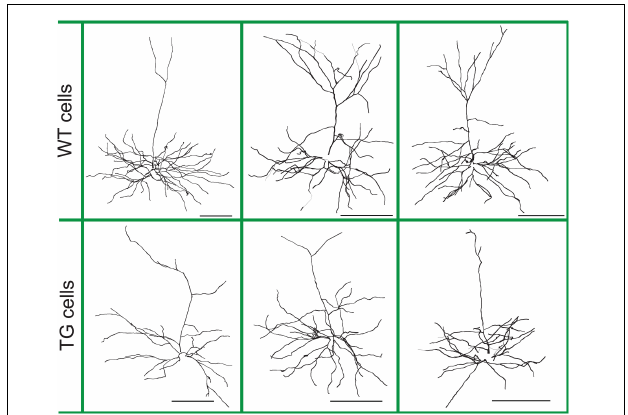
FIGURE 1 | Morphology of layer III wild-type (WT) and transgenic (TG) neurons of Tg4510 mice. Representative neurons with illustrations of dendritic diameters. Neurons are from the NeuroMorpho database (neuromorpho.org) and were 3D reconstructed and analyzed morphologically and electrophysiologically by Rocher et al. (2010) and Crimins et al. (2012). Scale bars are 100 µ